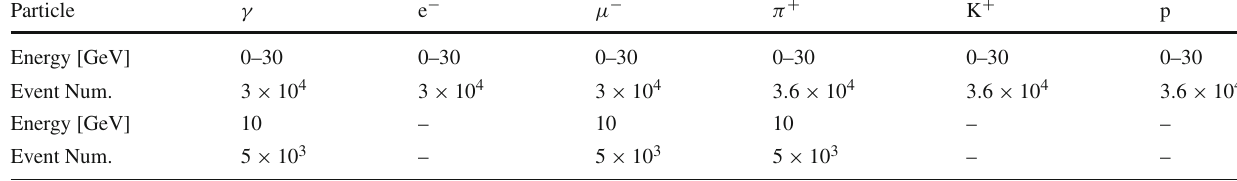
Table 2 Statistics of the simulated single particle samples. Six samples were generated with uniformly distributed incident momentum, while three samples with single incident momentum